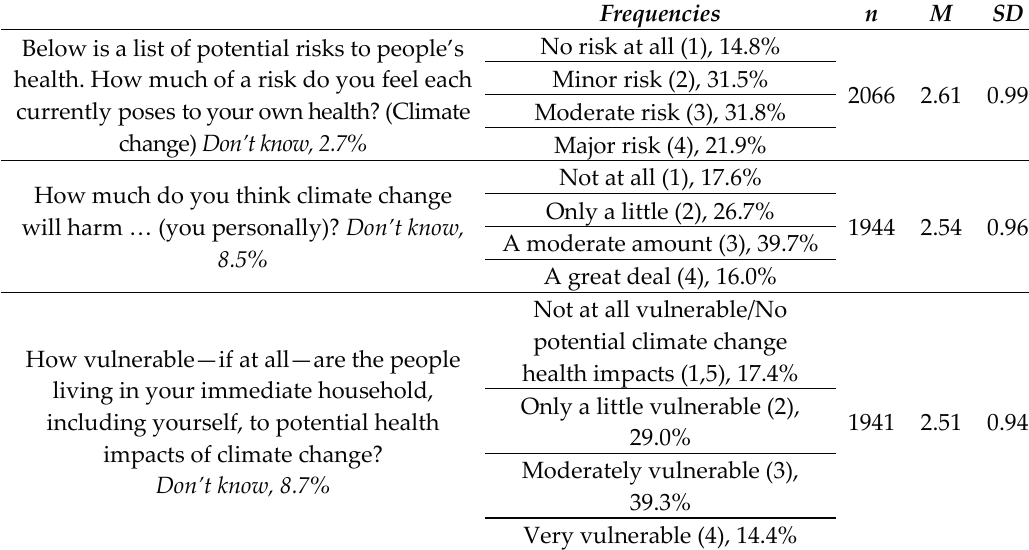
Table 2. Perceived vulnerability to climate change health risks (Dependent Variable): Factor score